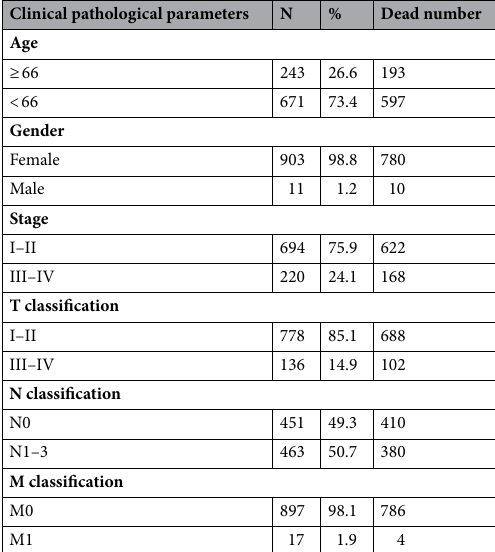
Table 3. Clinical pathological parameters of patients with Breast cancer in this study.